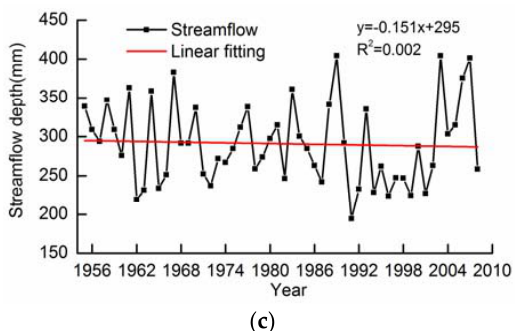
Figure 3. Annual variabilities of precipitation, temperature, and streamflow. ( a ) Precipitation; ( b ) Temperature; ( c ) Streamflow. Table 2. Changing trends of precipitation, temperature, and streamflow.